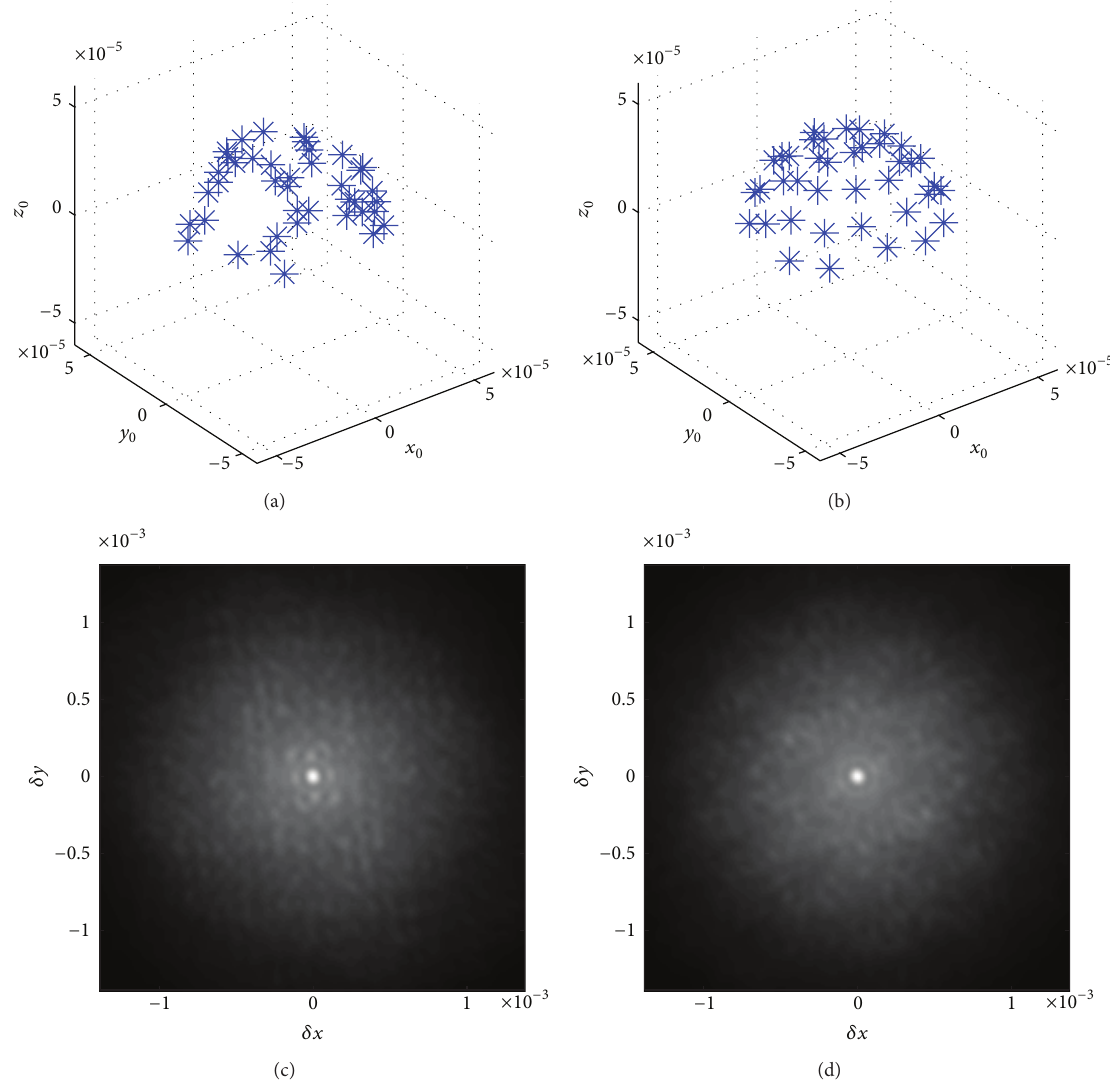
Figure 7: Half spheres composed of 40 Dirac emitters randomly located (a) or uniformly located over the half sphere (b). Autocorrelations of the speckle-like interferometric out-of-focus patterns that they create: (c) and (d), respectively. The radius of the half spheres is 40 micrometers. All axes are expressed in